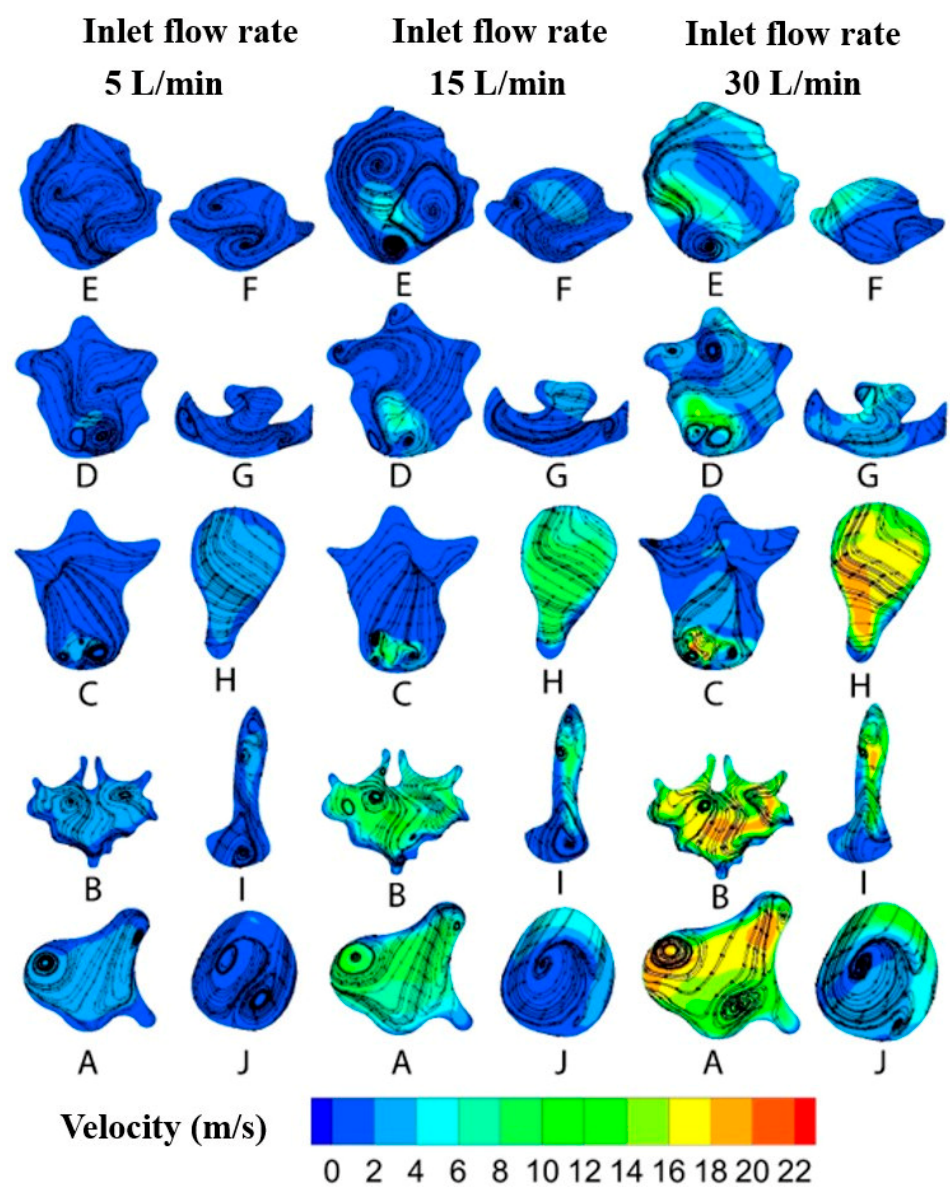
Figure 8. Velocity magnitude alongside streamlines at different flow rates in the SST transient viscous model.